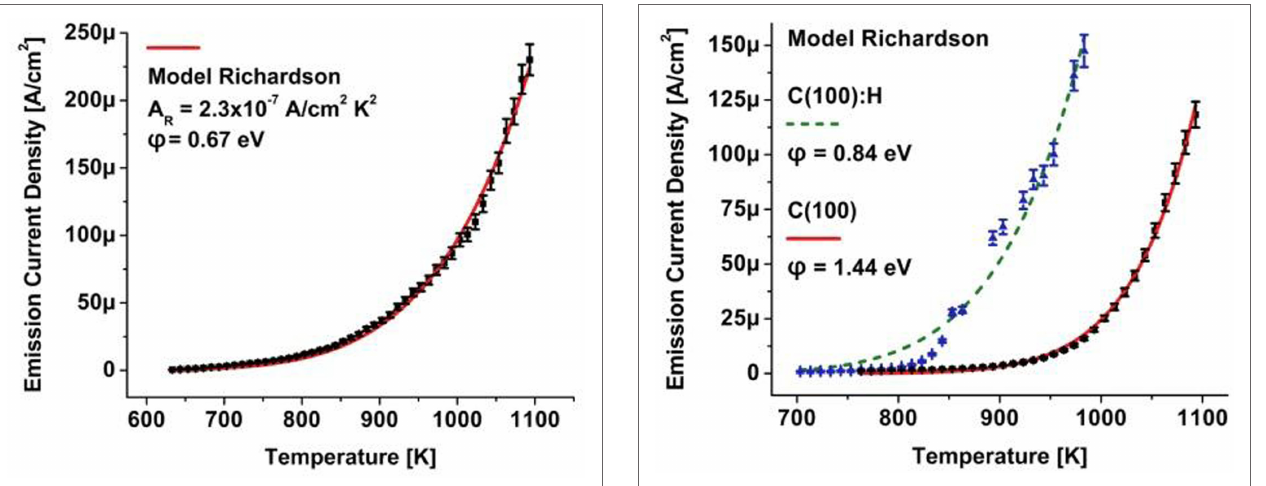
FIGURE 6 | Thermionic electron emission (square data points) from a phosphorus-doped diamond film with negative electron affinity surface grown on a high-pressure, high temperature (100) nitrogen-doped, single-crystal diamond substrate. A fit to the Richardson relation (solid curve) communicates a work function of ϕ = 0.67eV.